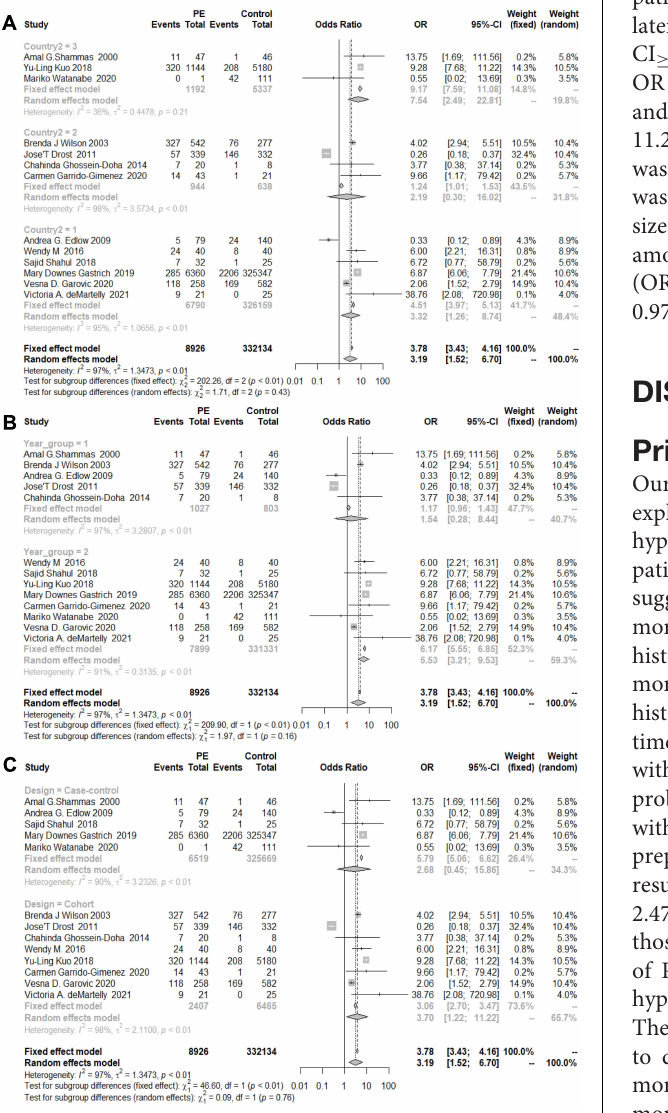
FIGURE 10 | (A) Subgroup analysis by region of the risk of developing chronic hypertension in the PE group (1 = North and South America, 2 = Europe, 3 = Asia). (B) Subgroup analysis by publication year of the risk of developing chronic hypertension in the PE group (Group 1 = years < 2016, Group 2 = years ≥ 2016). (C) Subgroup analysis by the study design of the risk of developing chronic hypertension in the PE